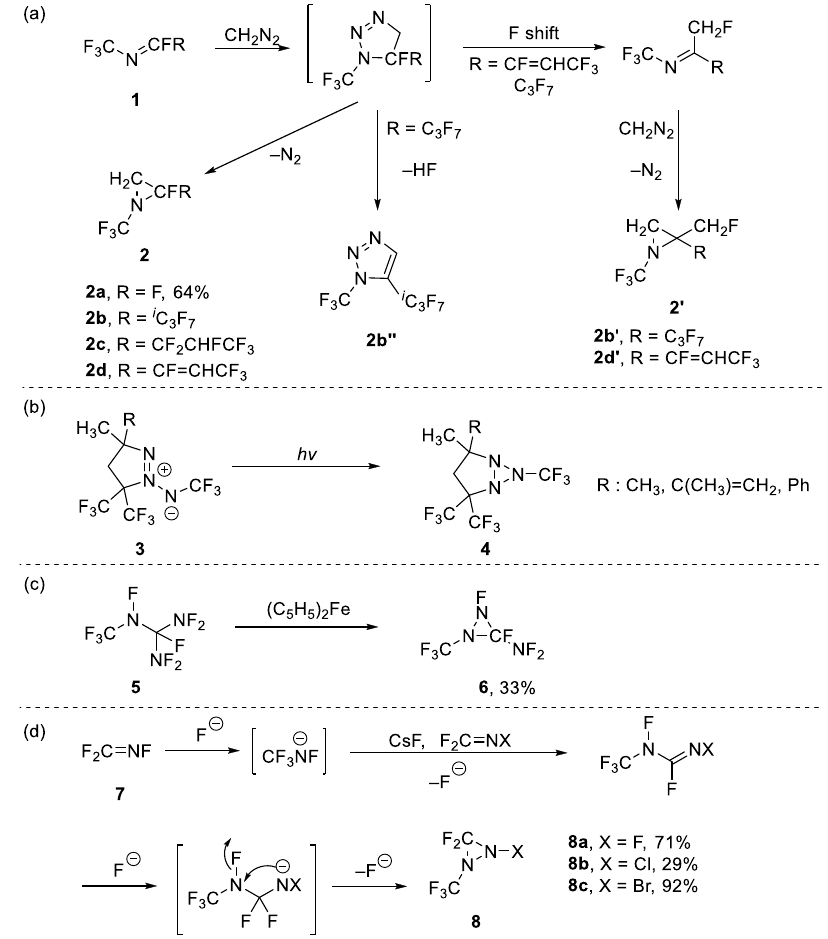
Scheme 1. Synthesis of ( a ) aziridines, ( b ) triziridines and ( c , d ) diaziridines.